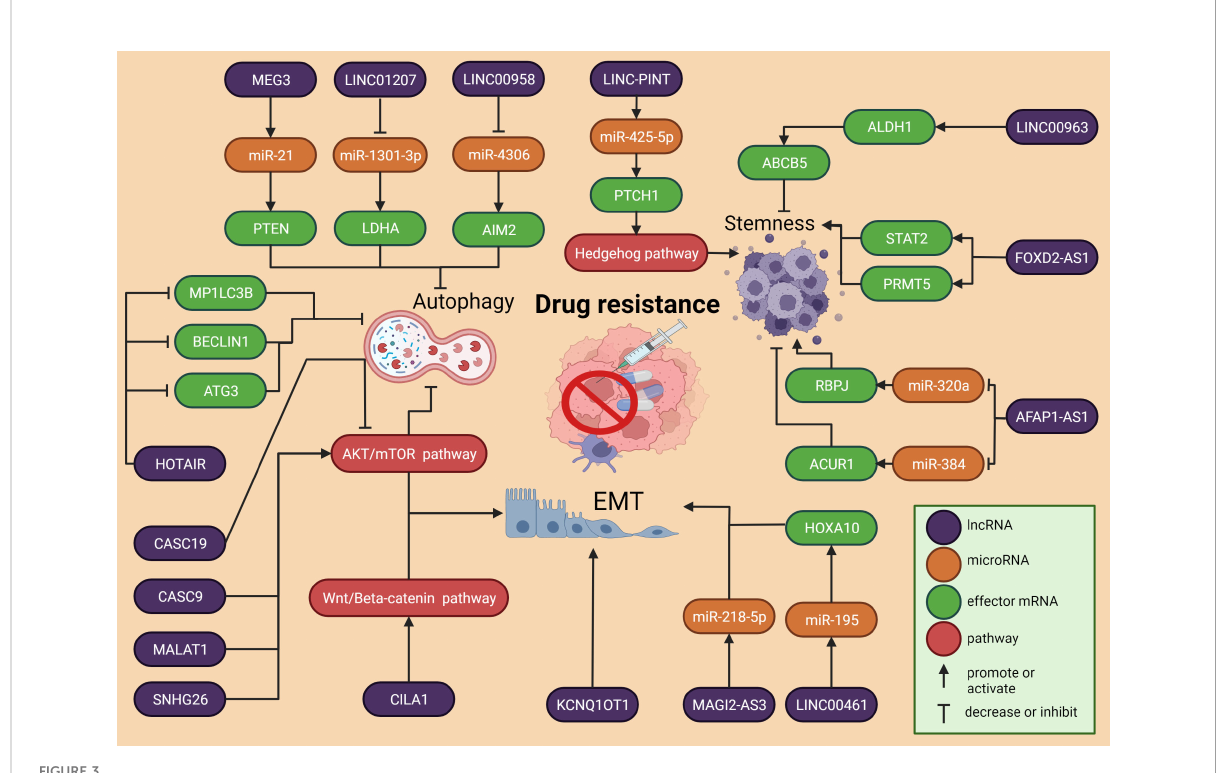
FIGURE 3 Overview of the molecular mechanisms of lncRNA in HSCC drug resistance. Three of the most important cellular processes involved with drug resistance are autophagy, EMT and stemness. All of them are ruled by regulatory axes that comprise the interaction between lncRNAs, microRNAs and expression of